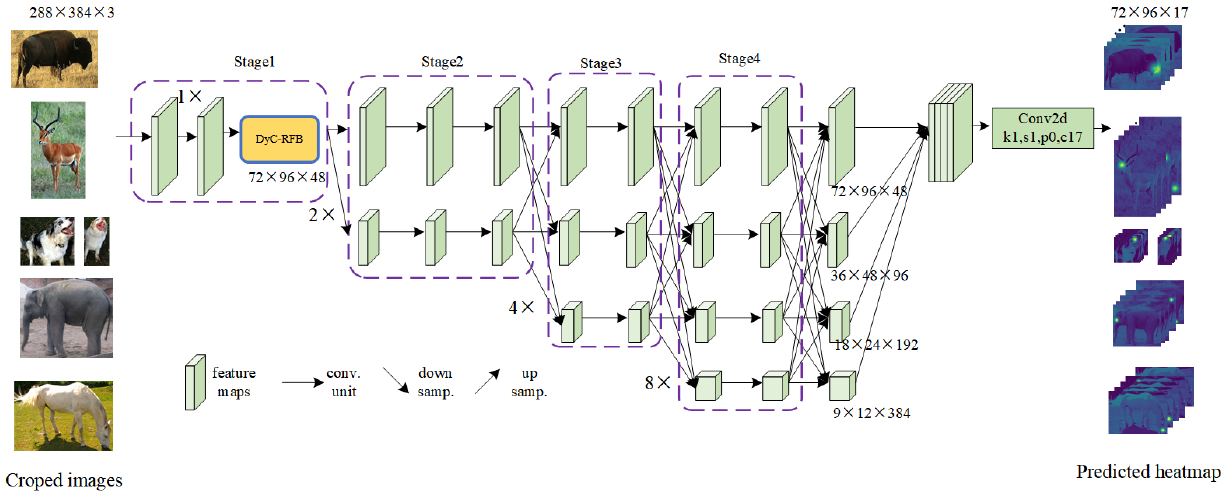
Figure 2. RFB-HRNet network structure.